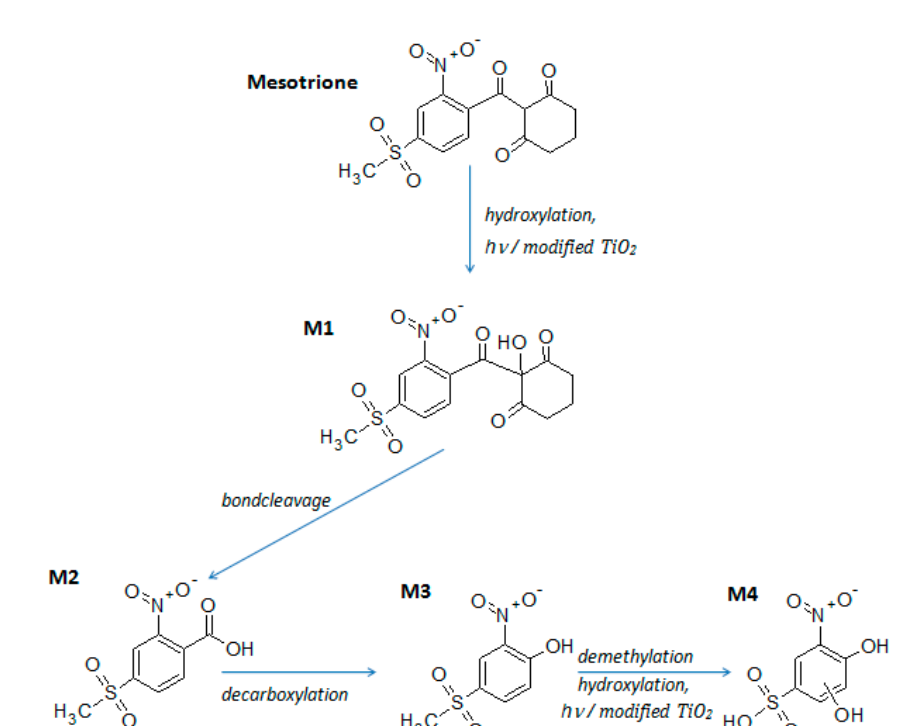
Figure 8. Mesotrione and its stable products detected during the process of photocatalytic degradation in the presence of 2.43 × 10 − 3 % Au–S–CH 2 –CH 2 –OH / TiO 2 (0.5 g / L) under simulated sunlight.